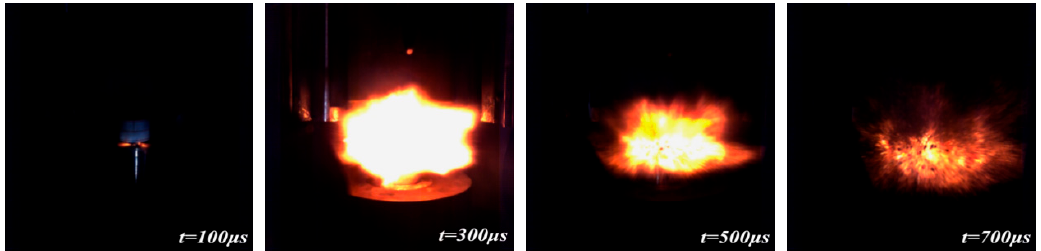
Figure 12. Reaction process of PTFE/Al/MoO 3 specimens under drop-weight tests.